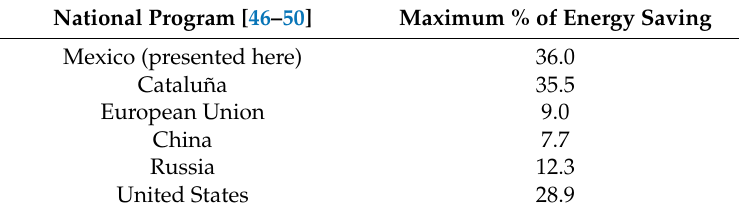
Table 8. Comparison of different energy savings at large scale for different regions.